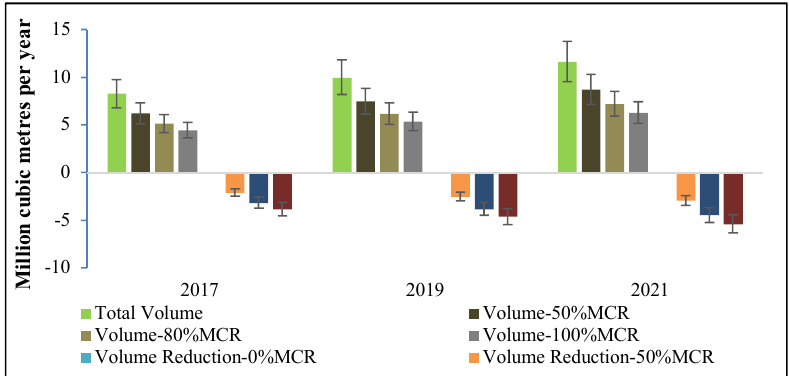
Figure 7. The total estimated volume of biodegradable wastes before and after moisture reduction. Standard deviation for the volume of the biodegradable wastes is ±18%; MCR: Moisture reduction.